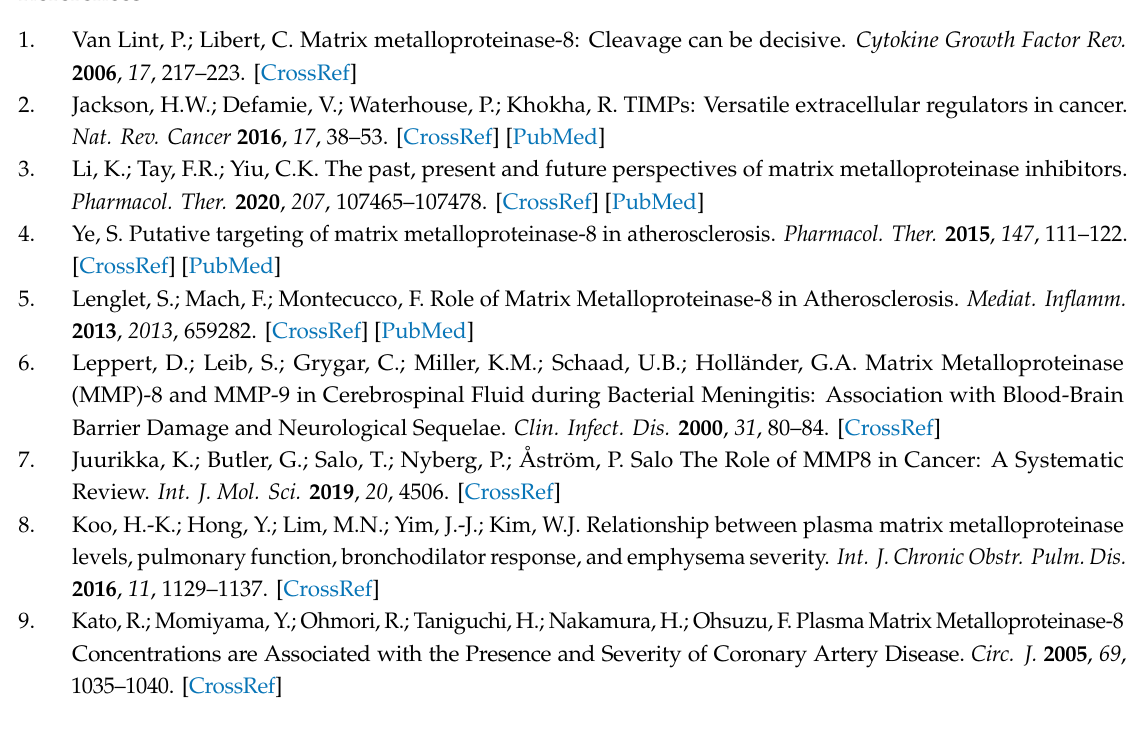
Figure S1: Comparison of the mode of binding of 38 and 43 on MMP-8. Figure S2: Mode of binding of the top five NSGM inhibitors ( 26 , 38 , 40 , 41 , and 42 ) of MMP-8 (shown in ESP map). Table S1: General structure of MMP-8 inhibitors developed to date, Table S2: List of interactions made by NSGMs with MMP-8. Author Contributions: S.M. performed the library screening, inhibition, and computational studies, and wrote the initial draft of the manuscript; U.R.D. finalized the manuscript, acquired funding, and directed the